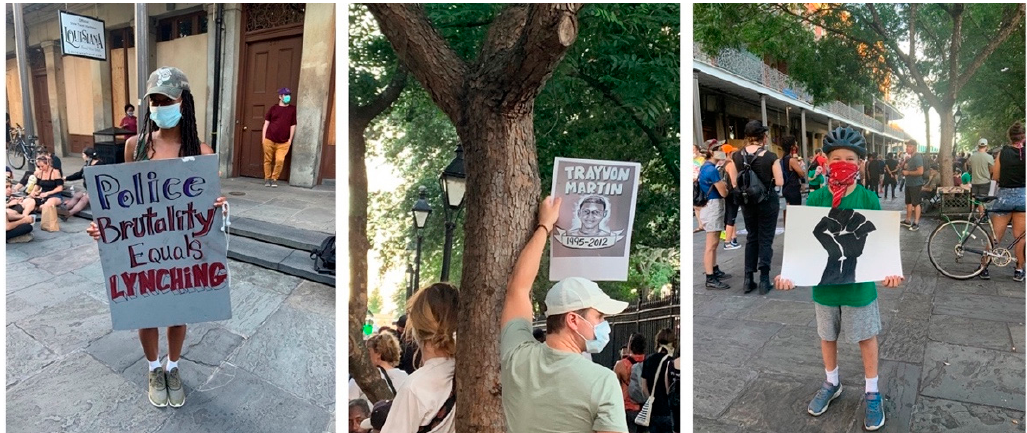
Figure 2. Signs at the Black Lives Matter protest on 5 June 2020 in the French Quarter of New Orleans. Right to left , Niya Zulu’s sign “Police Brutality Equals Lynching”; a poster linking deaths due to police brutality with other attacks on Black lives such as the shooting of 17-year-old Trayvon Martin; the author’s son, Max Etheridge, with a Black power sign that he painted. Photographs by Rachel Breunlin.